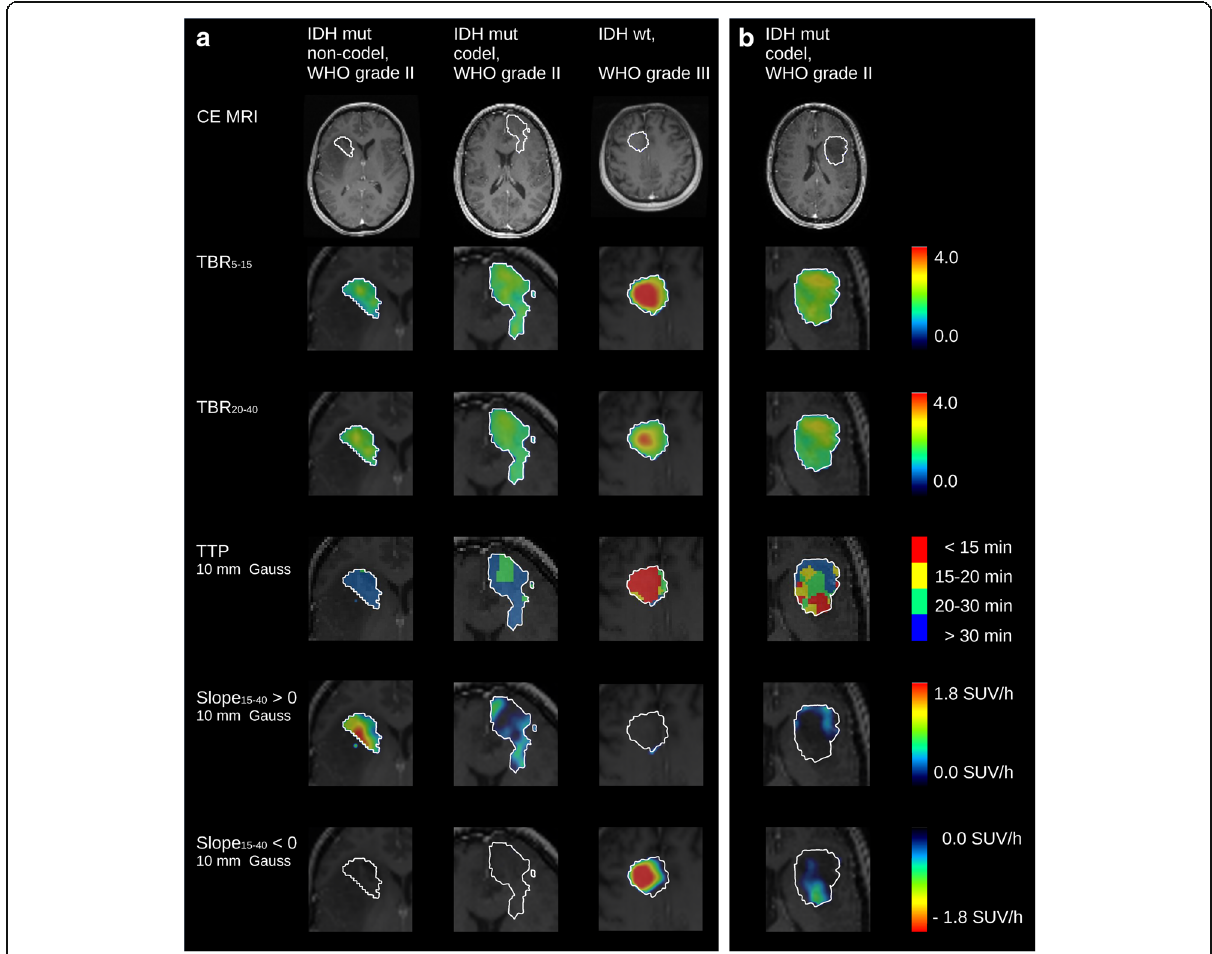
Fig. 5 Contrast-enhanced T 1 -weighted MRI images of four example patients, and the corresponding parametric images of the early and late TBR, the TTP, and the negative and positive Slope 15 – 40 for the voxels within the BTV (zoom factor 2; BTV marked with white contour; TTP and Slope 5 – 15 images estimated from dynamic PET data smoothed with a Gaussian with 10 mm FWHM). a Images of three example patients with parameter distributions characteristic of one IDH -mut non-codel WHO grade II glioma, one IDH -mut codel WHO grade II glioma, and one IDH -wt WHO grade III glioma. b One example patient ( IDH -mut codel WHO grade II glioma) with a mixed pattern in parametric images, where maximum uptake in TBR images does not co-localise with the hotspot with early TTP and negative Slope 15 –